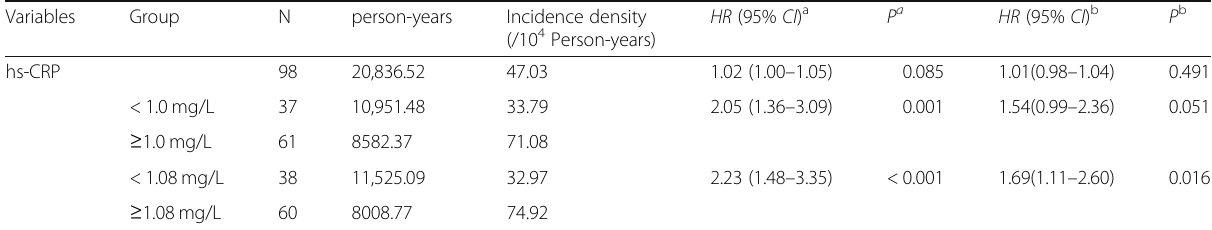
Table 3 Association analysis of hs-CRP with CHD in the follow-up study Variables